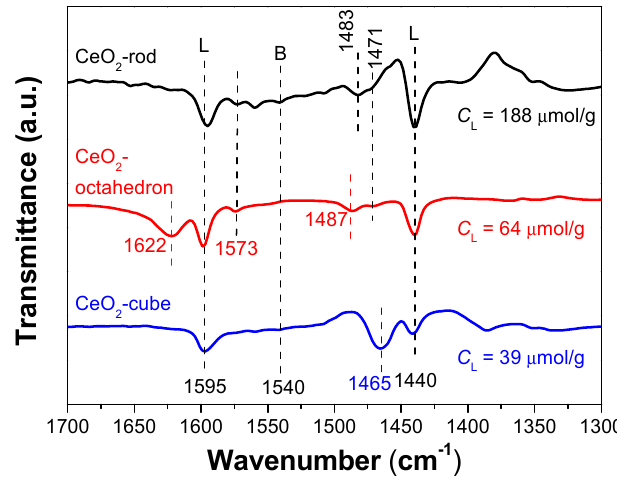
Figure 4. Pyridine adsorption IR spectra of CeO 2 with different morphologies.